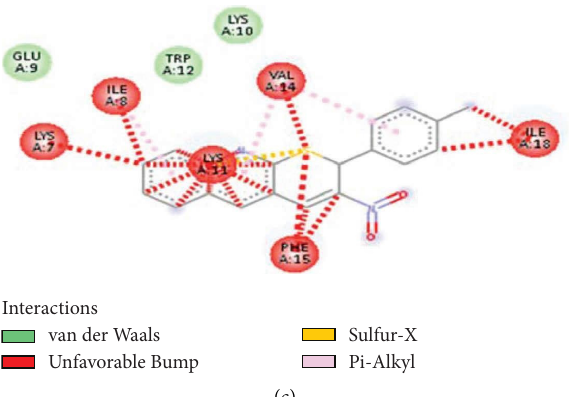
Figure 6: Te binding interaction of 3-nitro-2-(4-chloro)phenyl-2 H -thiopyrano[2,3- b ]quinoline ( 4 ) against CB1a ( PDB ID: 2IGR ) (a) receptor cavities present during interaction, (b) interaction of protein and ligand, and (c)